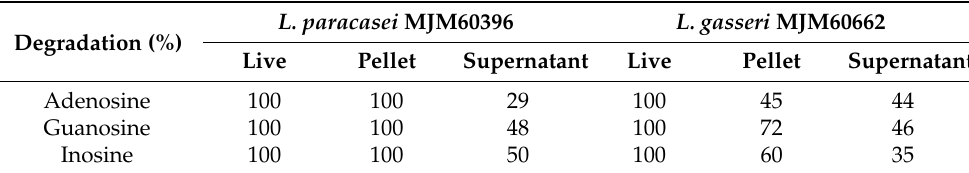
Table 3. The degrading effect of live cells, cell lysis pellets, and cell lysis supernatants on adenosine, inosine, and guanosine.